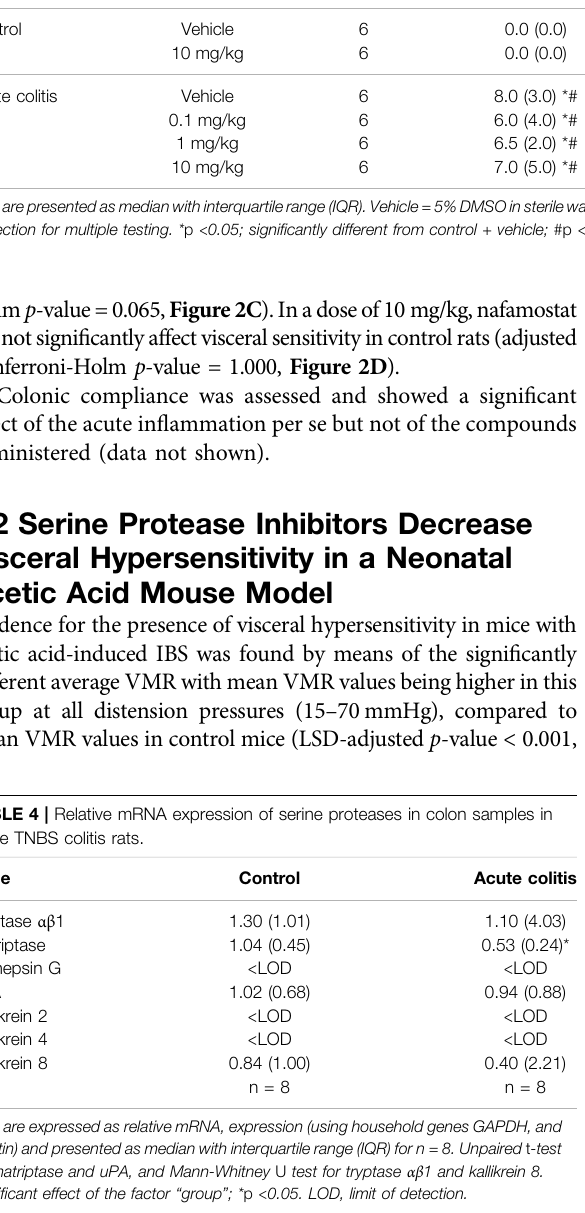
TABLE 3 | In fl ammatory parameters of all animals included in the acute TNBS colitis + nafamostat experiment. Group